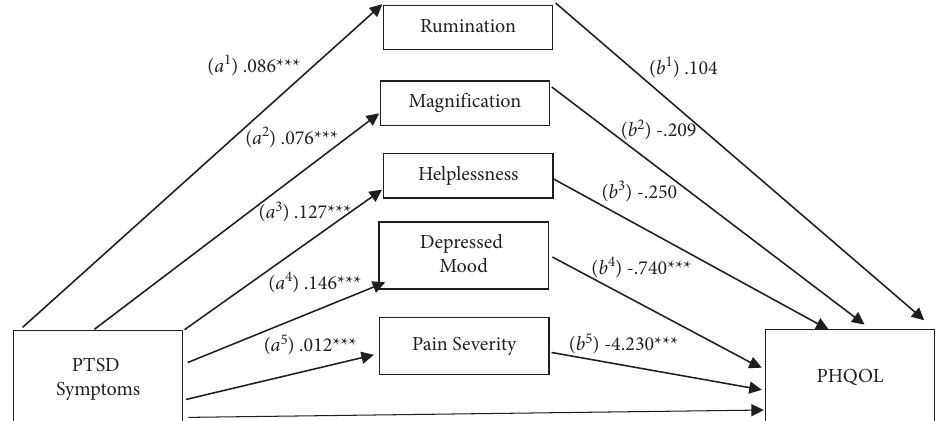
Figure 3: Mediation of the relationship between PTSD symptomatology and physical health-related quality of life (PHQOL) by pain catastrophizing subscales, depressed mood, and pain severity.